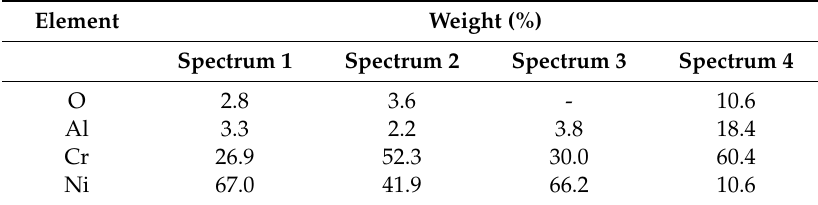
Figure 2. SEM micrographs of NiCrAl alloy foam ( a ) at low, ( b ) high magnification, ( c ) and after FIB (focused ion beam) milling. (focused ion beam) milling. Table 2. EDX microanalysis of NiCrAl